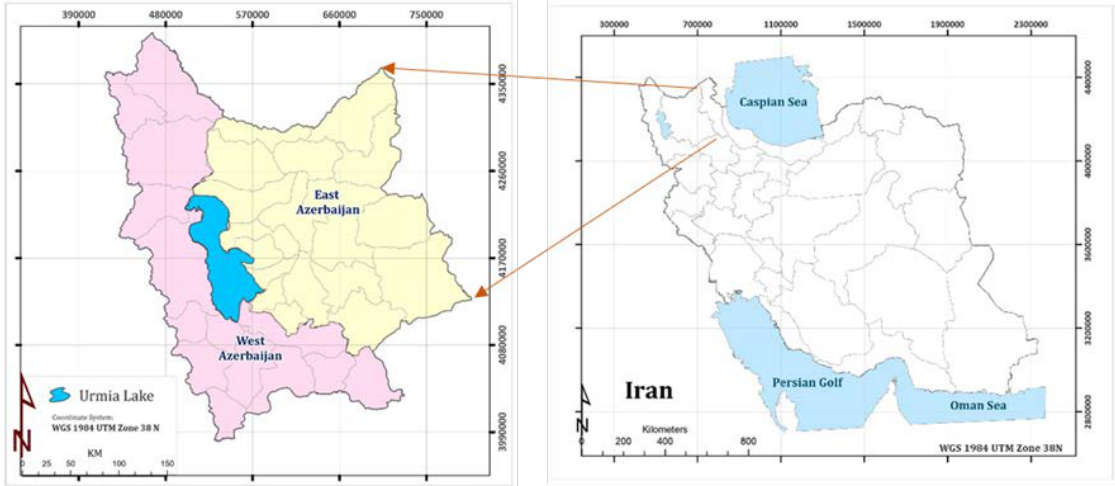
Figure 1. Geographic overview of Lake